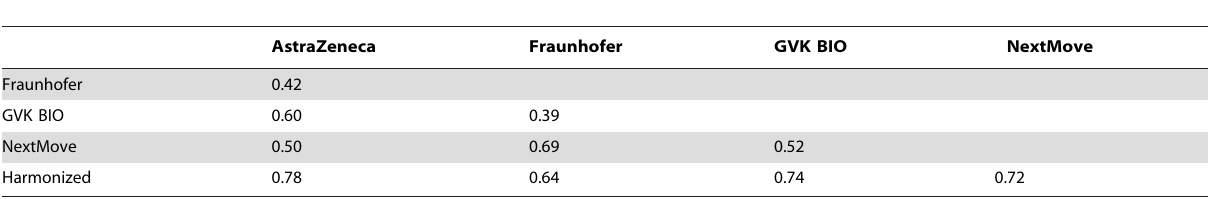
Table 3. Inter-annotator agreement (F-score) without ambiguity resolution.